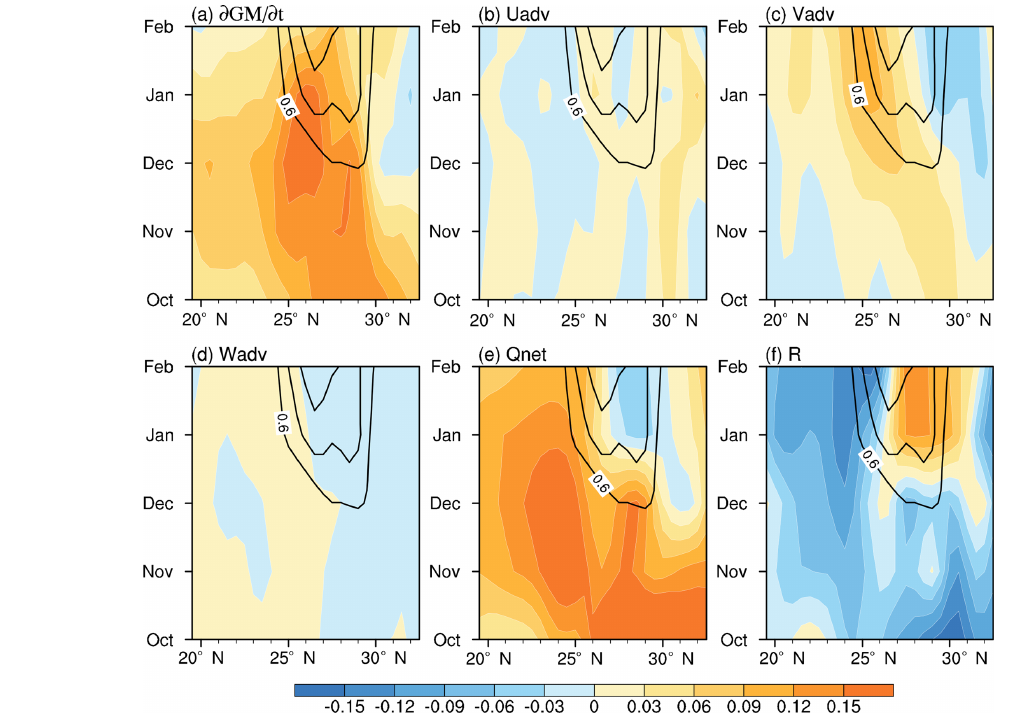
Figure 5. Same as Fig. 4, except for the terms (units: ◦ C(100km) − 1 month − 1 ) in Eq.